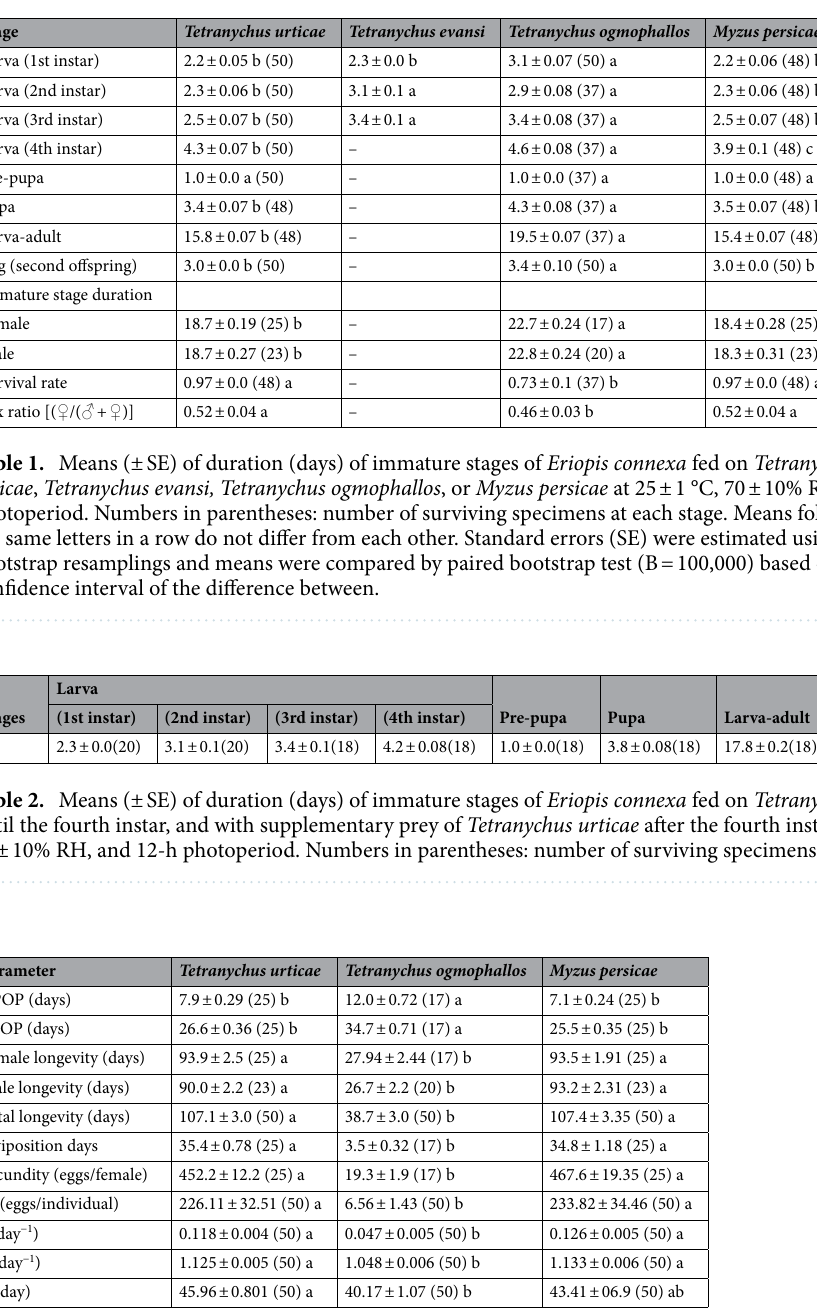
Table 3. Means (± SE) of duration (days) of pre-oviposition period (APOP), total pre-oviposition (TPOP), longevity, oviposition days, fecundity and life-table parameters of Eriopis connexa fed on Tetranychus urticae , Tetranychus ogmophallos , or Myzus persicae at 25 ± 1 °C, 70 ± 10% RH, and 12-h photoperiod. Numbers in parentheses: number of individuals for a respective parameter. Means followed by the same letters in a row do not differ from each other. Standard errors (SE) were estimated using 100,000 bootstrap resamplings and means were compared by paired bootstrap test (B = 100,000) based on 95% confidence interval of the difference between. Numbers in parentheses: number of surviving specimens at each